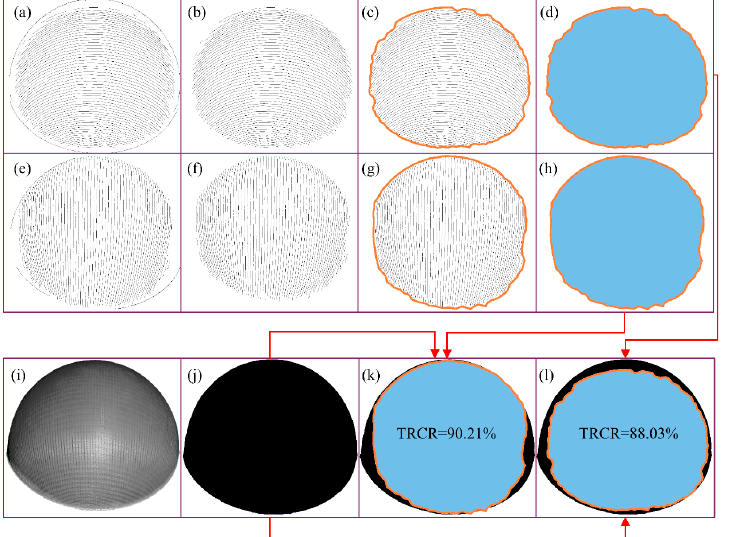
Figure 10. Calculation of the TRCR in reconstructed 0° region: ( a ) reconstruction result of weft yarn paths; ( b ) delete the edge contour of the sample from weft reconstruction result; ( c ) establish recon- struction area boundary in weft reconstruction result; ( d ) calculate the area of weft direction recon- struction area; ( e ) reconstruction result of warp yarn paths; ( f ) delete the edge contour of the sample from warp reconstruction result; ( g ) establish reconstruction area boundary in warp reconstruction result; ( h ) calculate the area of warp direction reconstruction area; ( i ) original image of sample; ( j ) binary image of sample; ( k ) TRCR result of warp yarn paths; ( l ) TRCR result of weft yarn paths. Then, the sample’s image after removing the background is binarized, and the pixel area of the black pixel is calculated. For our example, this was 636,110 pixels, as shown in Figure 10j. Finally, the TRCR values of the weft and warp direction are computed, which are 88.03% and 90.21%, respectively (Figure 10k,l). In the same way, the TRCR values of the 90°, 180°, 270° regions are shown in Table 1.